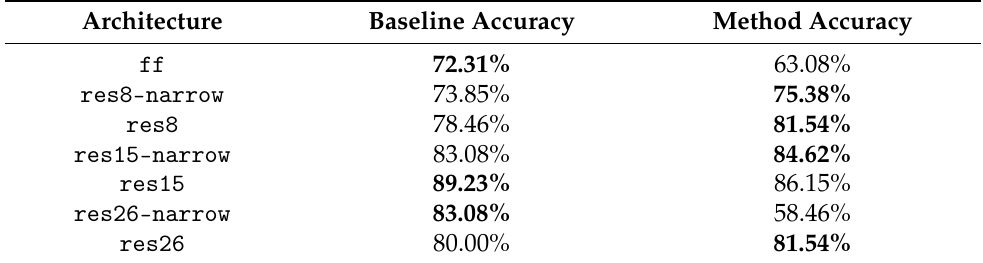
Table 11. Test accuracy after the training with the initial data set and added samples with pseudola- bels. The best result for each architecture is